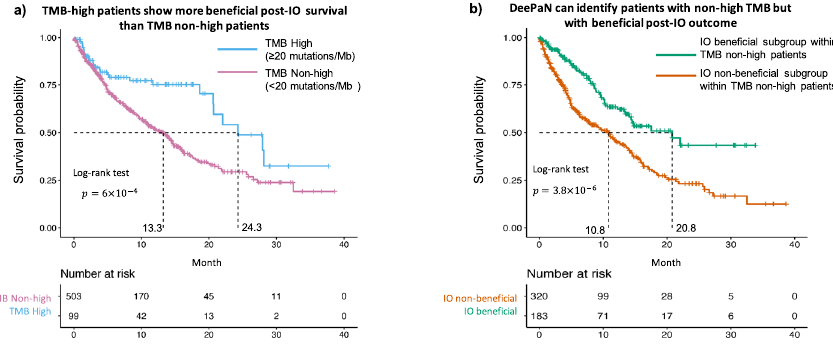
Fig. 4 DeePaN can identify patients with non-high TMB but with bene fi cial post-IO outcomes. a High tumor mutation burden (TMB) is associated with bene fi cial post-IO outcomes, as observed in the overall IO cohort (log-rank P -value of 6 × 10 − 4 , median survival of 13.3 vs. 24.3 months for TMB non-high vs. high groups, respectively). b DeePaN can identify patients with non-high TMB but with bene fi cial post-IO outcomes. Subgroups discovered by “ DeePaN ” are able to strategy TMB-non-high patients into subgroups with signi fi cantly differentiated survival post IO therapy ( P -value of 3.8 × 10 − 6 from log-rank test, median survival of 20.8 months and 10.8 months, respectively), with about 10 months ’ median survival difference between the IO-bene fi cial vs. non-bene fi cial